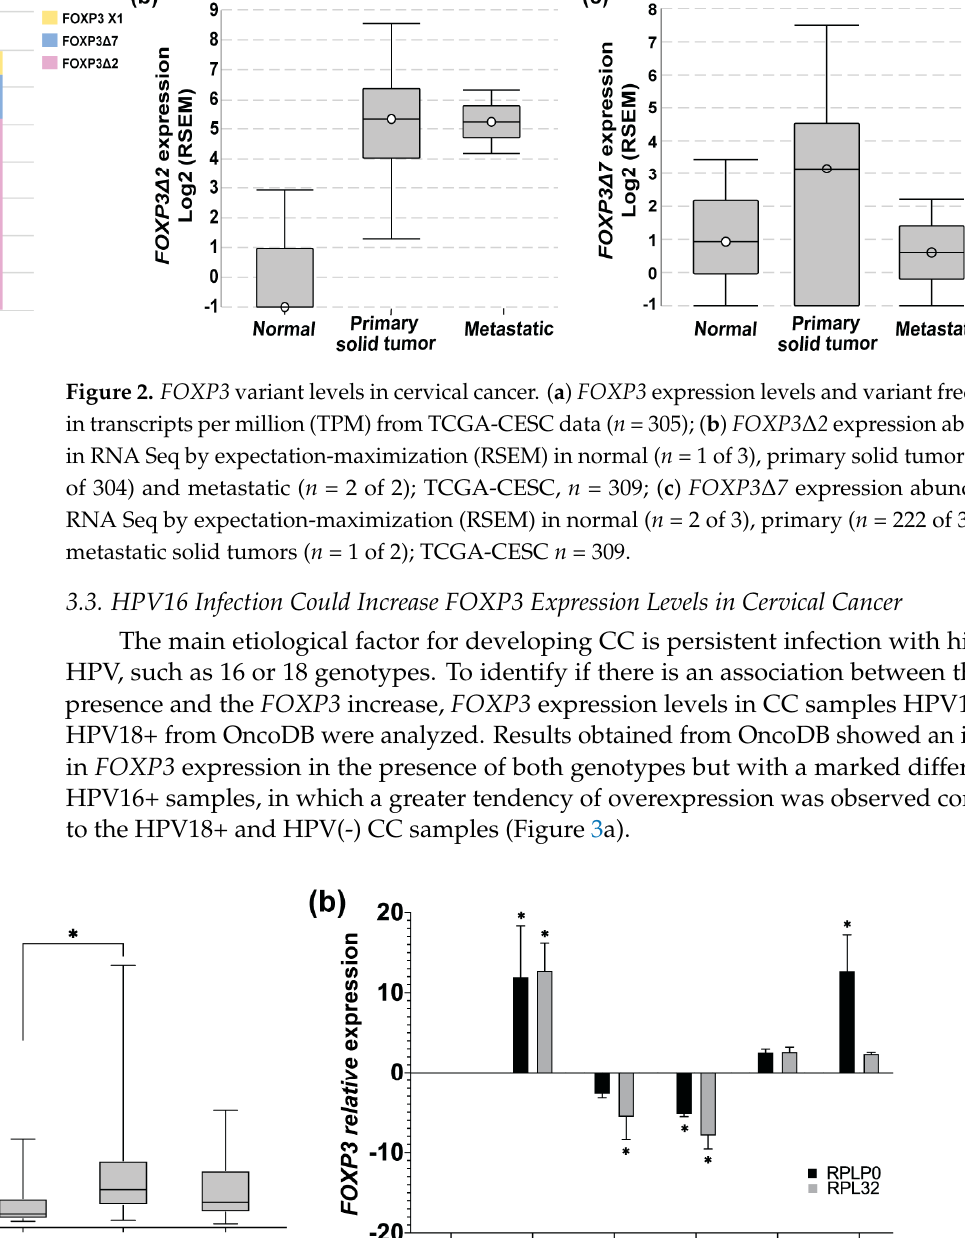
Figure 2. FOXP3 variant levels in cervical cancer. ( a ) FOXP3 expression levels and variant frequen- cies in transcripts per million (TPM) from TCGA-CESC data ( n = 305); ( b ) FOXP3 Δ 2 expression abundance in RNA Seq by expectation-maximization (RSEM) in normal ( n = 1 of 3), primary solid tumor ( n = 273 of 304) and metastatic ( n = 2 of 2); TCGA-CESC, n = 309; ( c ) FOXP3 Δ 7 expression abundance in RNA Seq by expectation-maximization (RSEM) in normal ( n = 2 of 3), primary ( n = 222 of 304), and metastatic solid tumors ( n = 1 of 2); TCGA-CESC n = 309.